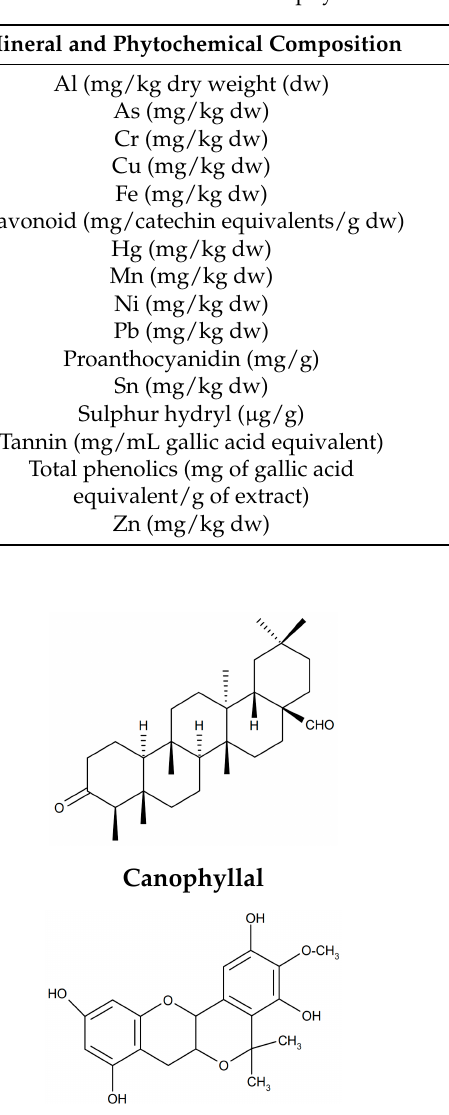
Table 3. Phytochemical composition of Elaeodendron transvaalense.